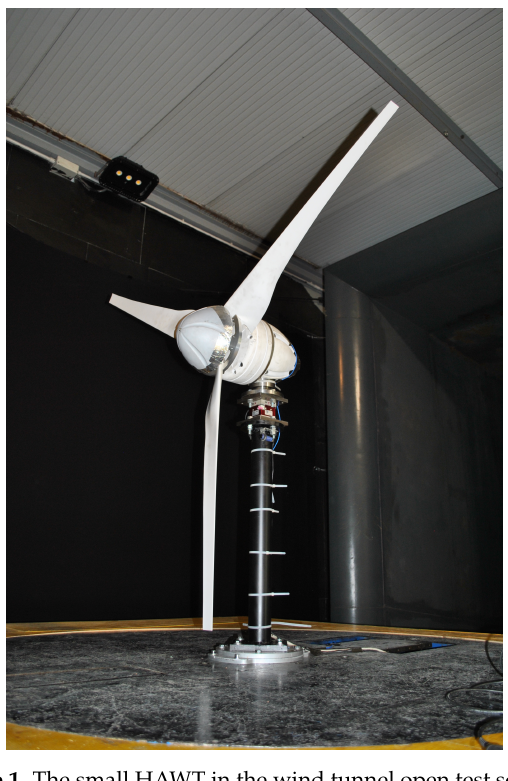
Figure 1. The small HAWT in the wind tunnel open test section.